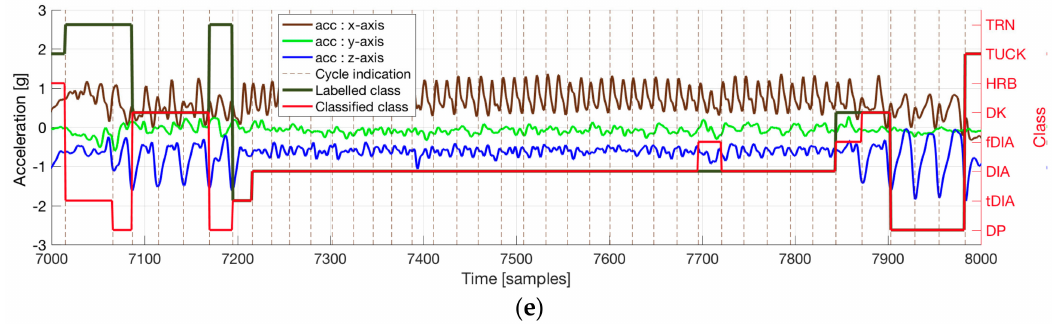
Figure A2. The entire test dataset from subject 7 at Sognefjellet is plotted in ( a ), while ( b – e ) show an enlarged view of the parts of the dataset where most misclassifications occur.